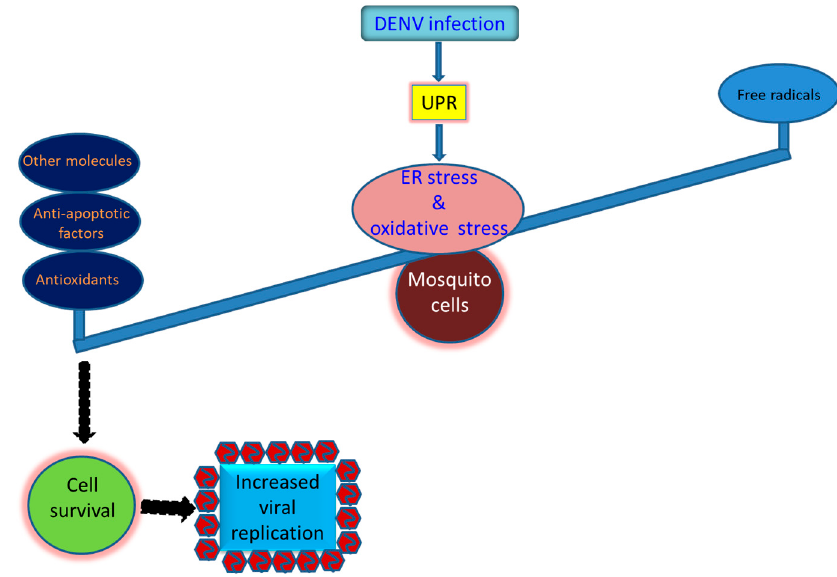
Figure 3. Strategies that utilized by the mosquito cells to survive the infection by the dengue virus and other arboviruses. Prosperous replication of the virus in mosquito cells is required for its sustainability in nature. However, it is dependent on the mosquito vector that can bear the burden of the oxidative stress induced by the virus infection, resulting in normally cellular growth and productive virus replication. Antioxidant defense in infected mosquito cells is generally induced to adjust the redox status of the cells to adjust cellular homeostasis. Antioxidants including SOD, CAT, and GPX are commonly upregulated in mosquito cells infected by the dengue virus. The anti-apoptotic effect involving upregulation of the inhibitor of apoptosis (IAP) and resultant reduction of caspase-9 and -3 activity can also be critical for infected cells to survive. More, other molecules such as glutathione S-transferase (GST), eukaryotic translation initiation factor 5A (eIF5a), and one paralogue of p53 (p53-2) can also be beneficial for mosquito cells to resist oxidative stress induced by the viral infection.